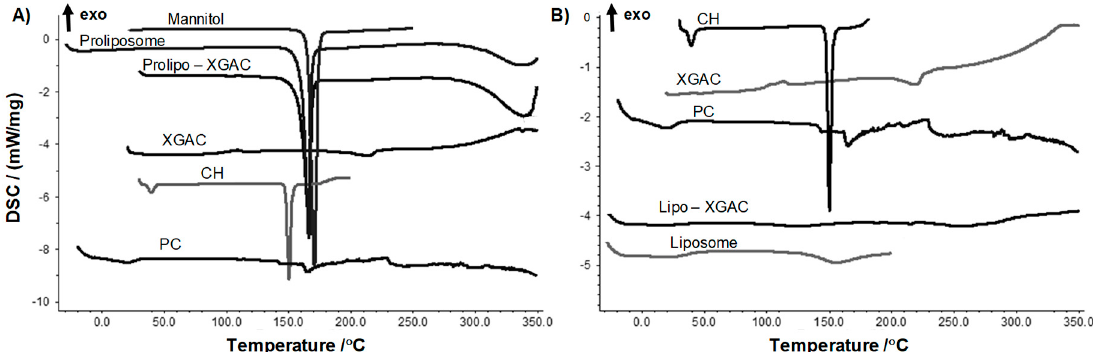
Figure 1. Mixture of the components of the proliposomal ( A ) and liposomal ( B ) formulation and their constituents. CH = cholesterol; PC = phosphatidylcholine; and XGAC = xanthone 2 .